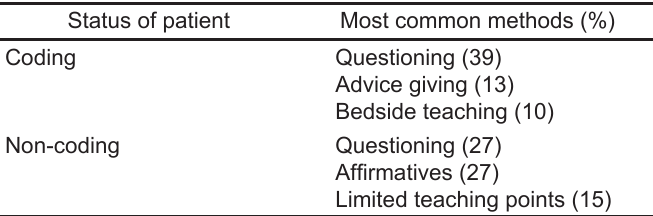
Table 4. Comparison of top three teaching methods used based on status of patient.